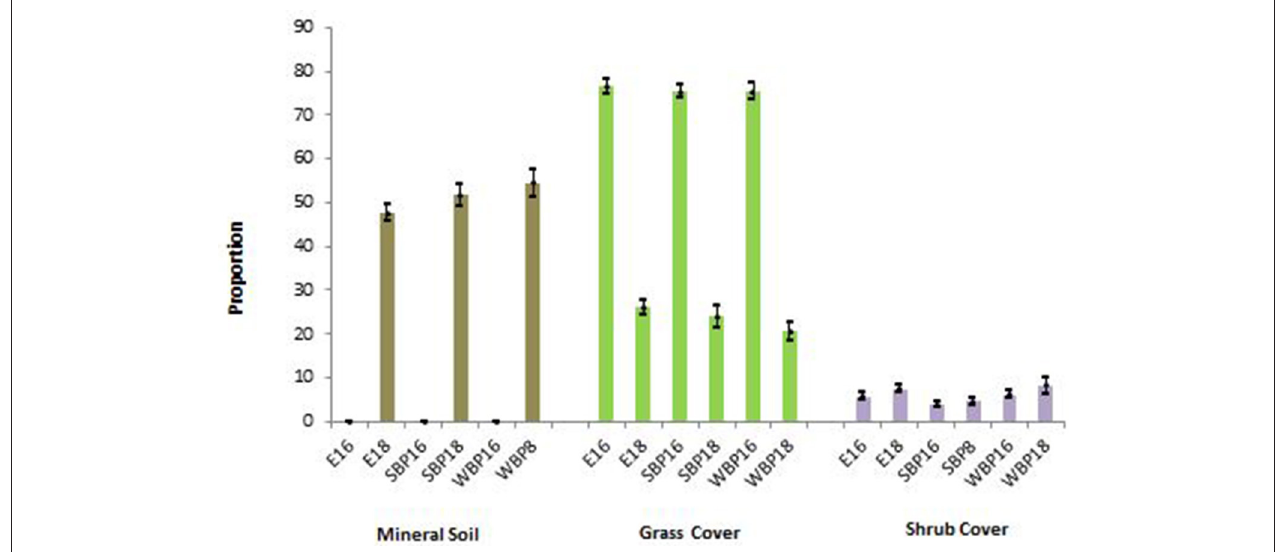
FIGURE 4 | Change in cover proportion by type and site on the Eskerine Complex prairie in Waterton Lakes National Park. E, Eskerine prairie plots; SBP, Summer Bison Paddock prairie plots; WBP, Winter Bison Paddock prairie plots; 18, the year 2018; 16, the year 2016. These sites are all located within the Eskerine Complex